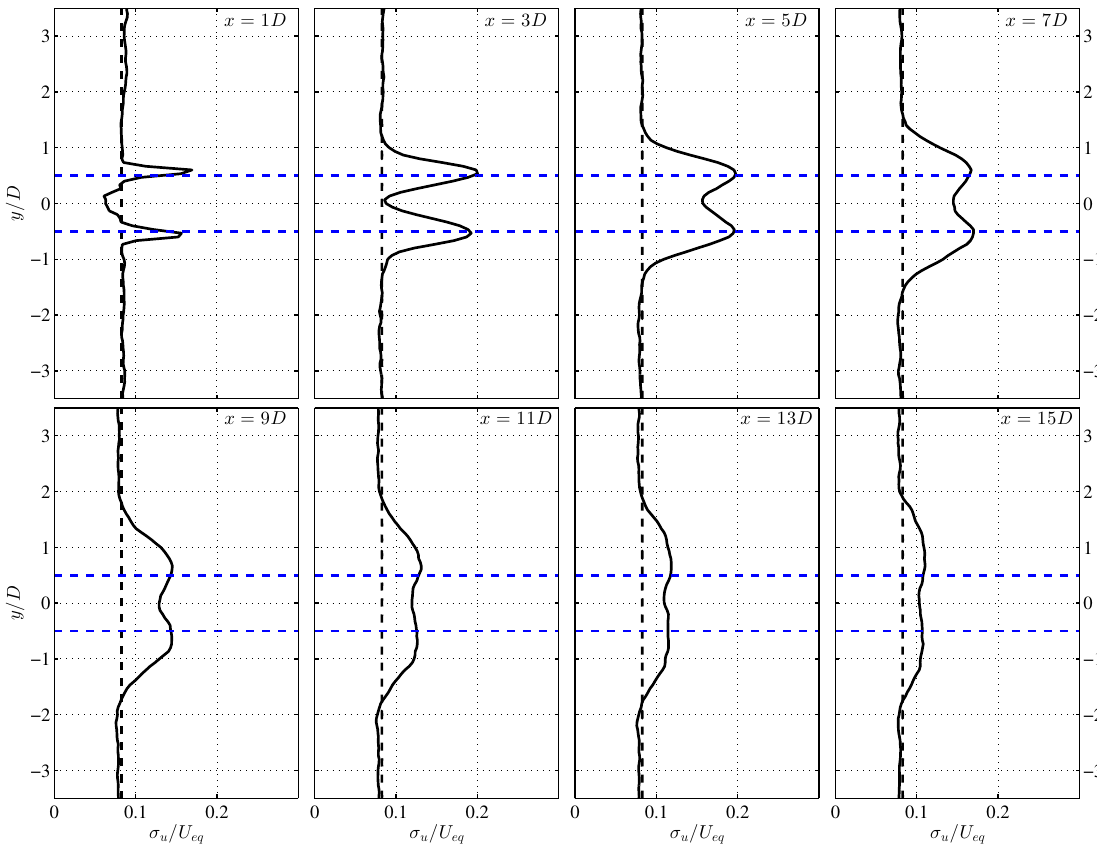
Figure 13. Horizontal profiles of the streamwise turbulence intensity in the x - y plane at the equator height of the turbine at different downstream positions. The black dashed line represents the inflow profile, and the blue horizontal dashed lines show the extent of the